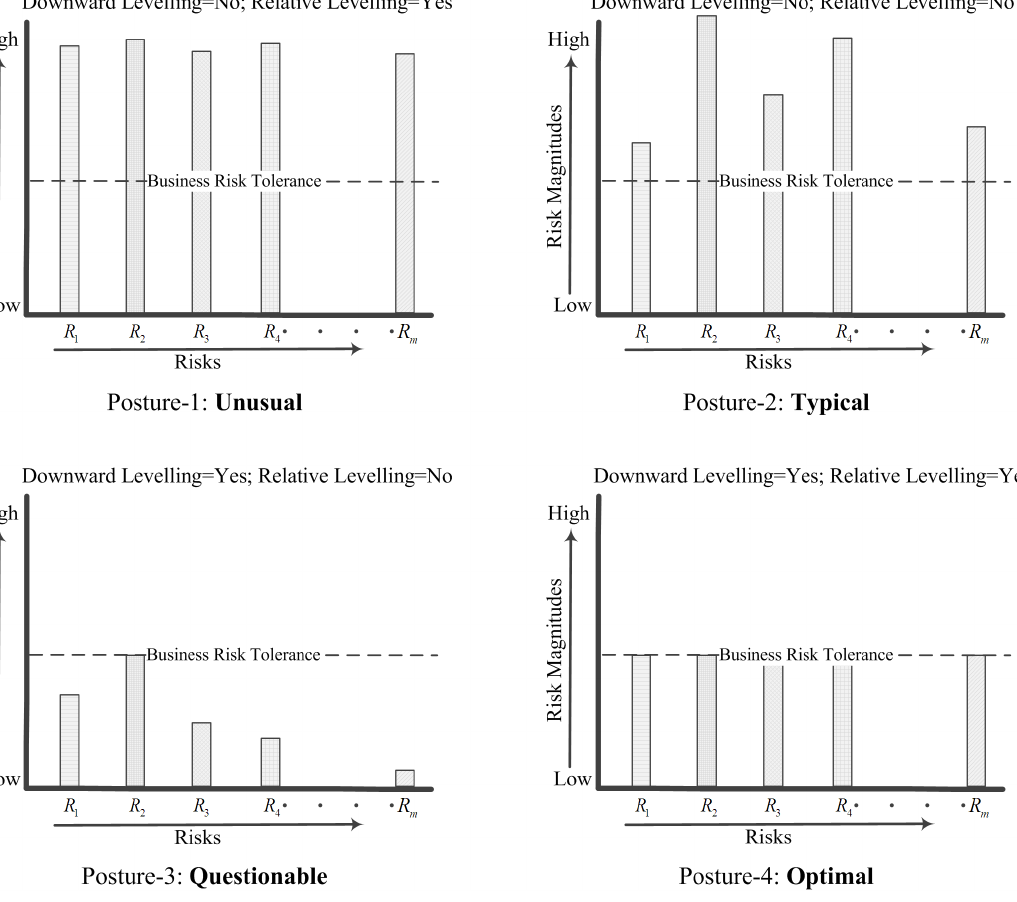
Figure 4. Four Market